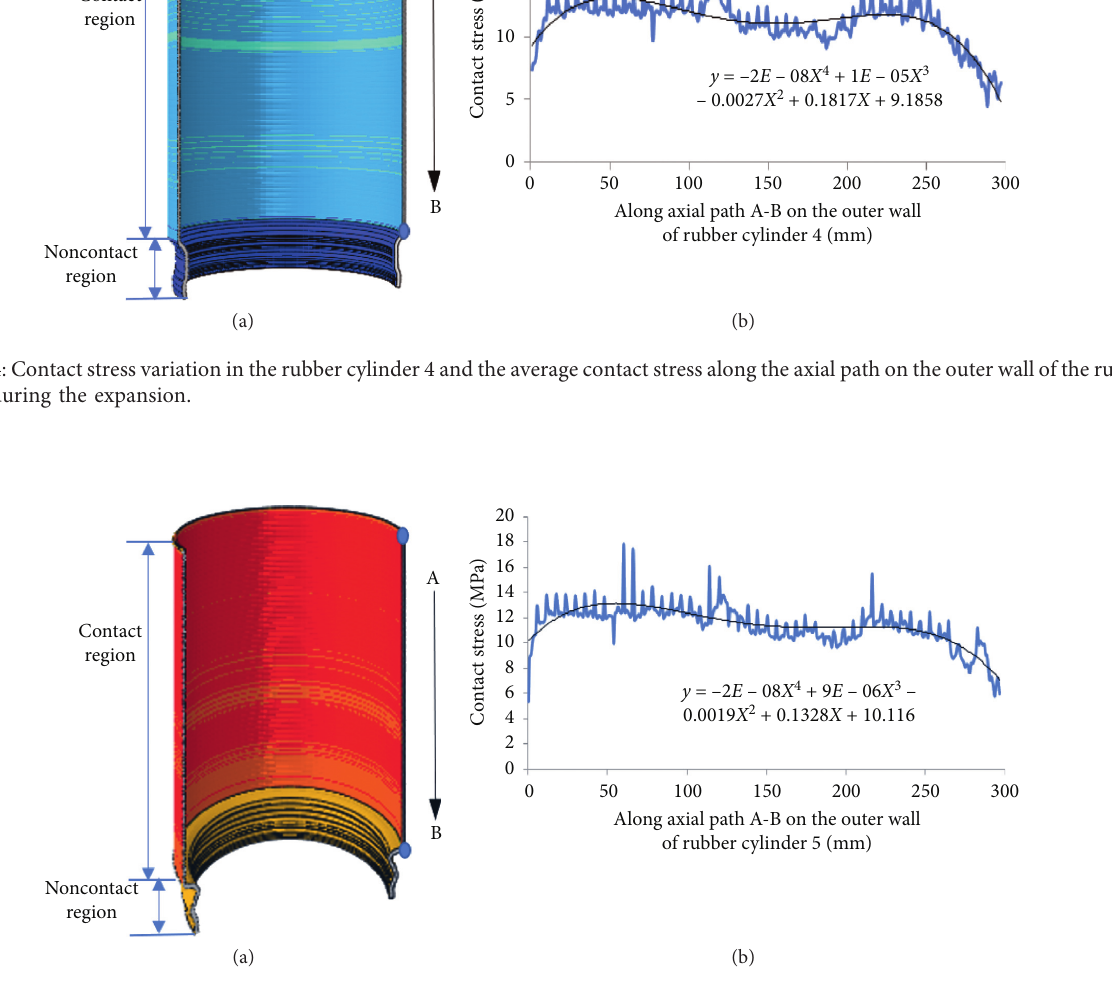
Figure 15: Contact stress variation in the rubber cylinder 5 and the average contact stress along the axial path on the outer wall of the rubber cylinder during the